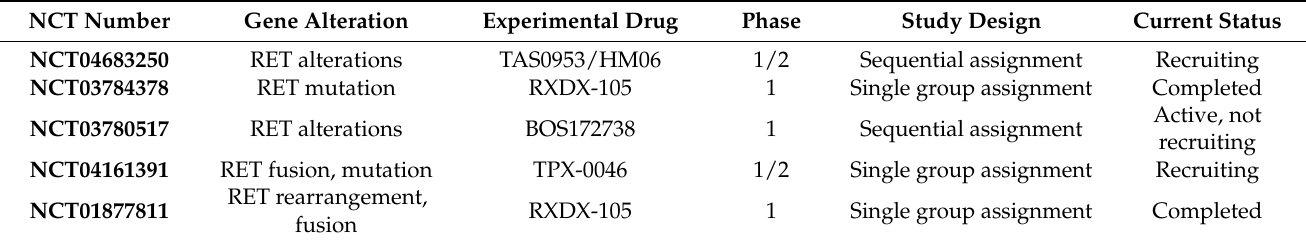
Table 3. Trials testing novel agents targeting RET fusions in